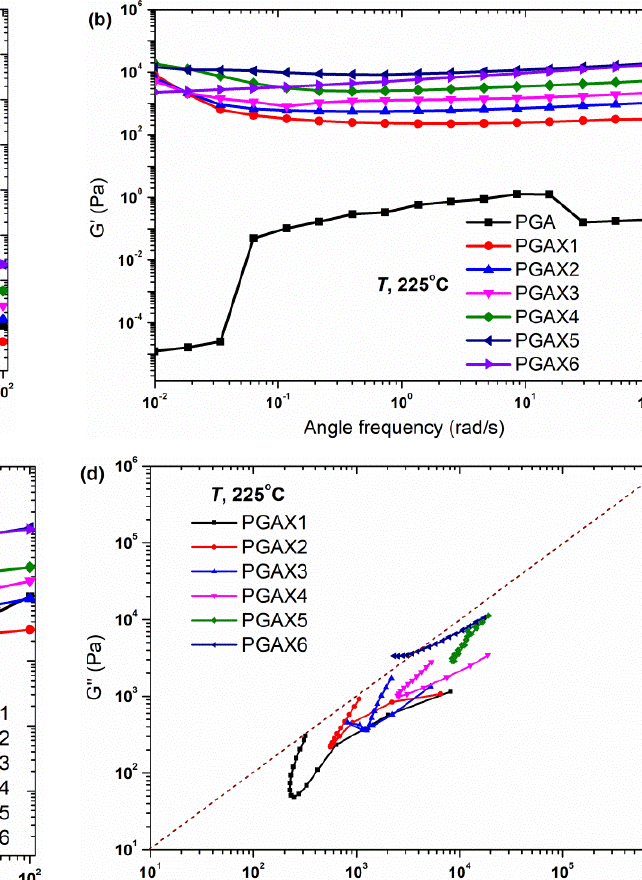
8 of 15 Figure 4. Rheological properties and DSC patterns of pristine PGA melt: ( a ) complex viscosity, ( b ) loss modulus, ( c ) storage modulus and ( d ) the DSC curves of PGA. The G ′ and G ″ behave with quite different behaviors with the shear rate, as shown in Figure 4b,c. The G ″ of PGA at certain temperature increases with the shear rate, while it decreases with the increase of the melt temperature. As to G ′ , however, the results show that the measurements could be instable. The fluctuation of the G ″ value is very obvious and remarkable. This reveals that the elasticity of the pristine PGA melt is rather low or even undetectable. The rheological behaviors of the PGAX blends are shown in Figure 5. The complex viscosity of PGAX increases with the increase in the PVA content and the shear-thinning behavior is much more remarkable. This implies that both the presence of PVA and POE greatly enhance the elasticity of the PGA melt. The measured viscosity increases from ~4.4 Pa·s for PGAX1 to 227.5 Pa·s for PGAX6 under 100 s − 1 . The G ′ is found to be increased by 3–4 orders of magnitude and the G ″ is increased by 2–3 orders of magnitude. The G ″ decreases slightly with the increase in the shear frequency until ~0.1 s − 1 and then in- creases. In the practical measuring process, the initial shear frequency was 100 s − 1 and then decreased gradually to 0.01 s − 1 . The whole test process took about 45 min. Therefore, the slight increase of G ″ from 0.1 to 0.01 s − 1 could be resulted from the thermal degrada-